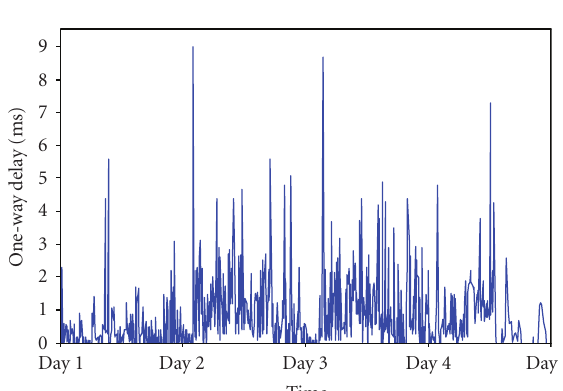
Figure 5: Remote microscopy testbed setup.